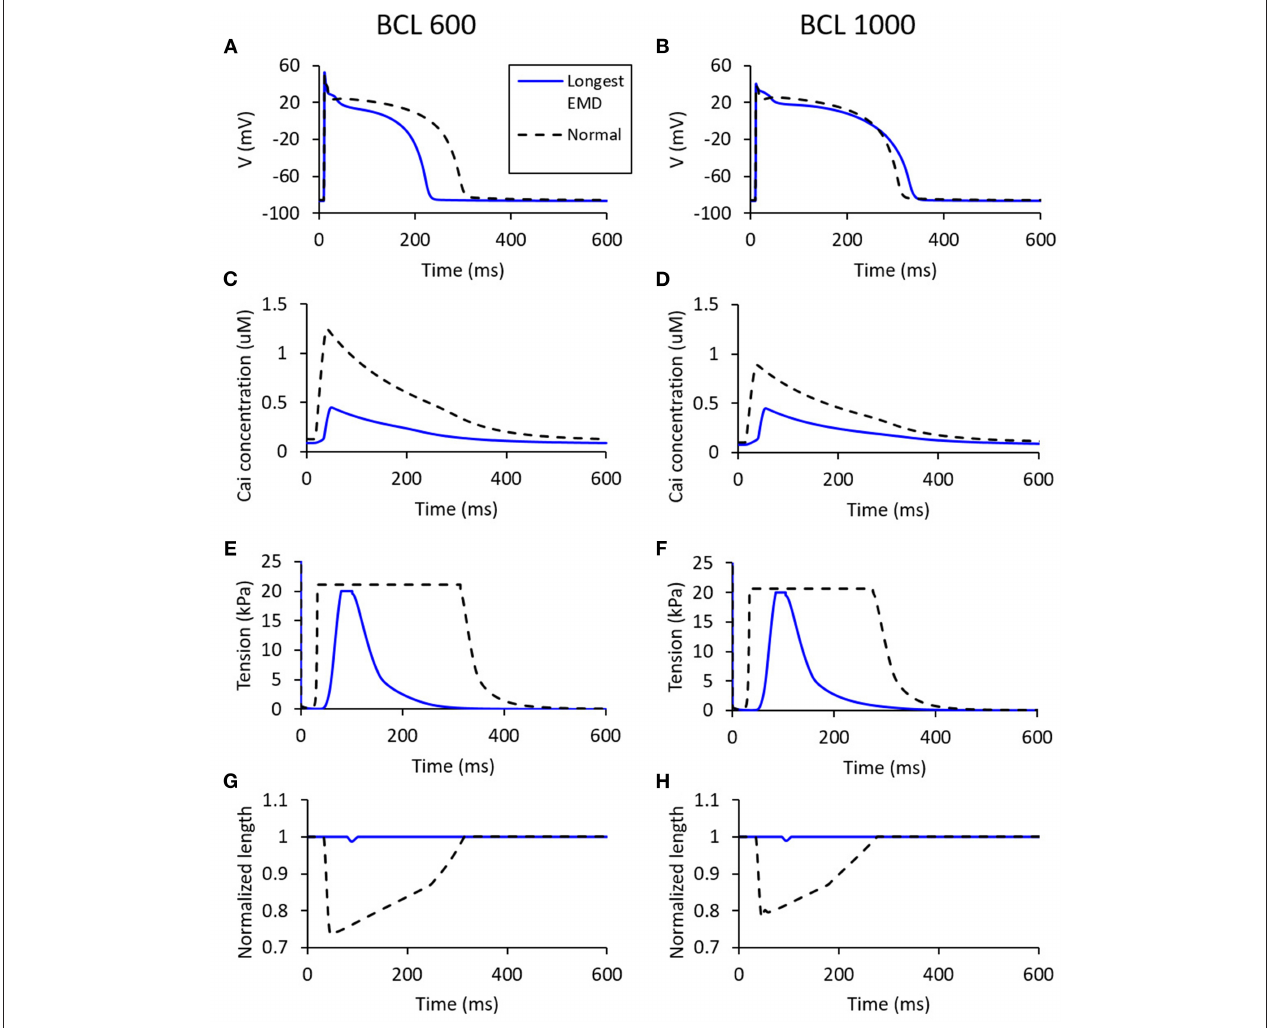
FIGURE 10 | The states for the longest EMD on each BCL variation [for BCL 600ms (A,C,E,G) and for BCL 1,000ms (B,D,F,H) ]. The blue line represents the states for a case with the longest EMD, while the dashed black line is the normal case with all channels set to 100% maximum